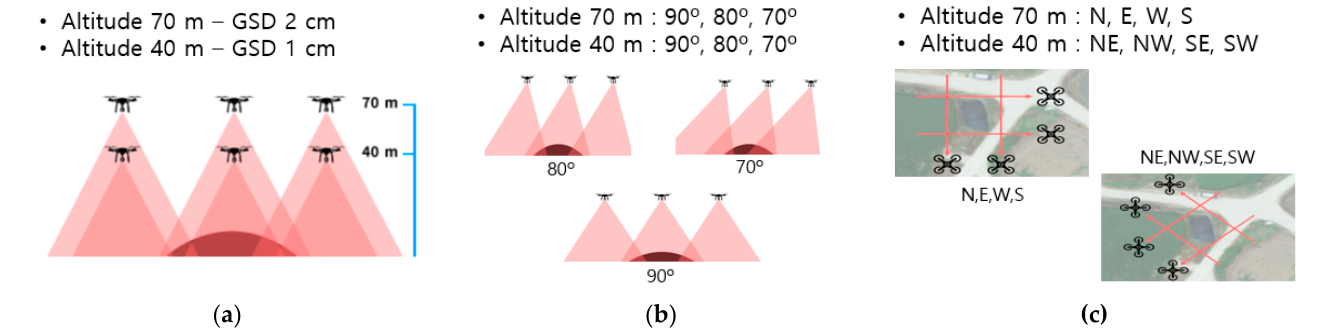
Figure 7. Data collection method: ( a ) photogrammetry per altitude ( b ) photogrammetry per angle ( c ) photogrammetry per direction. Table 1. Number of data collections.